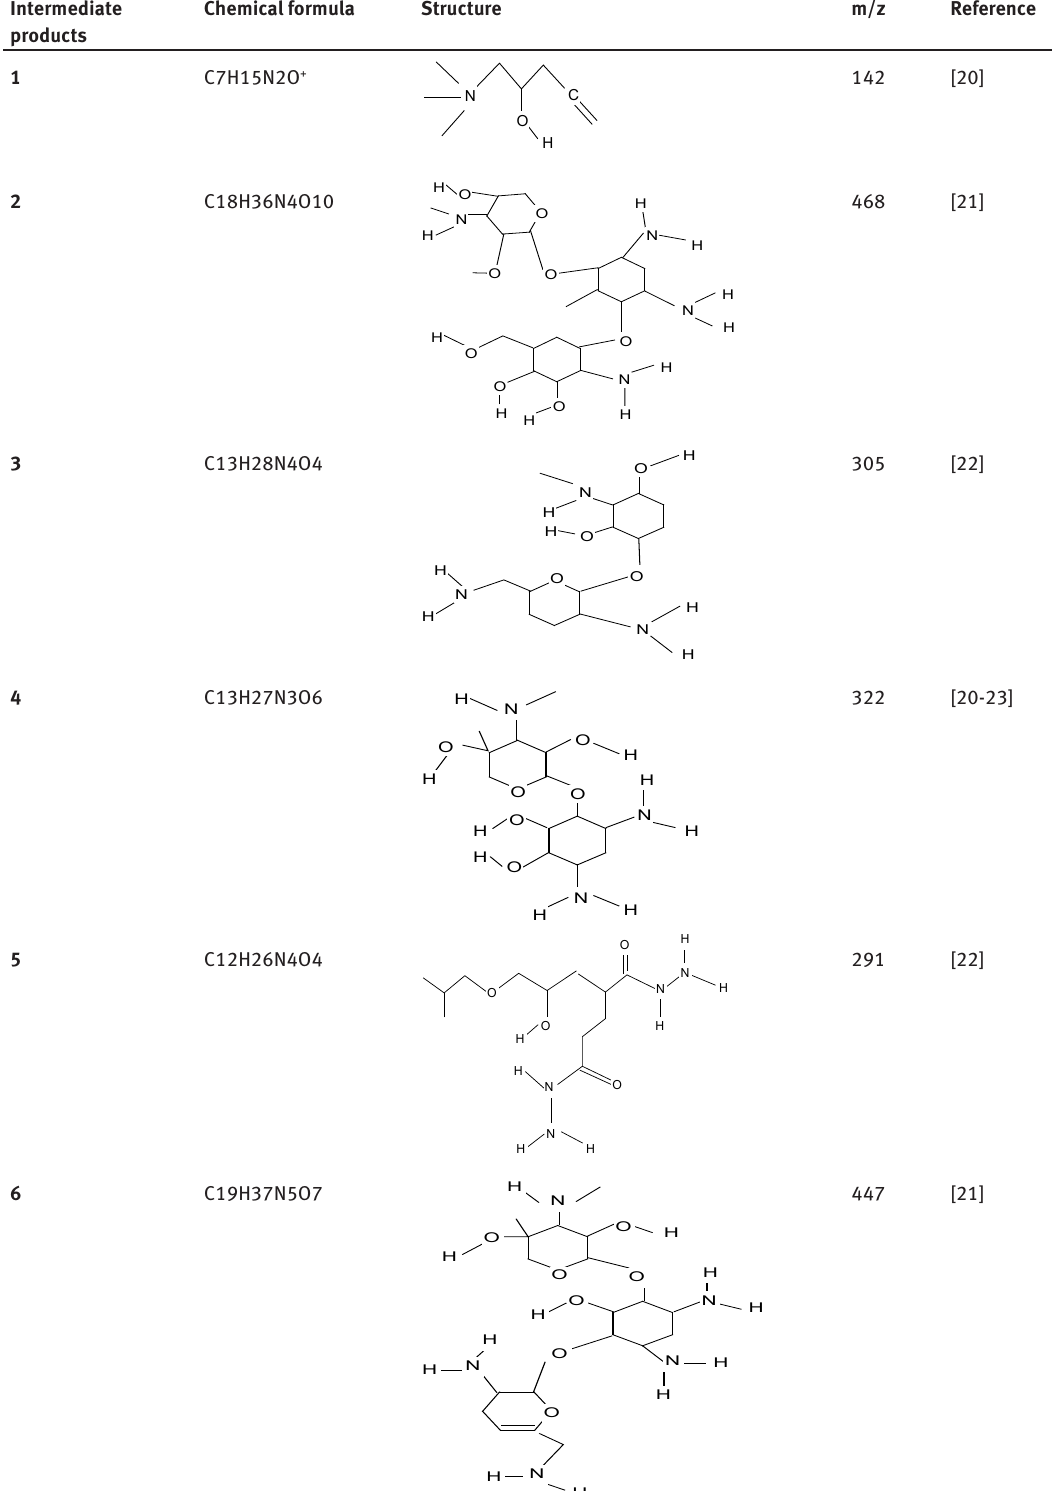
Table 1: The by-products identified by LC-MS/MS during the mineralization of the gentamicin during 60 min by the electro-Fenton process. Intermediate